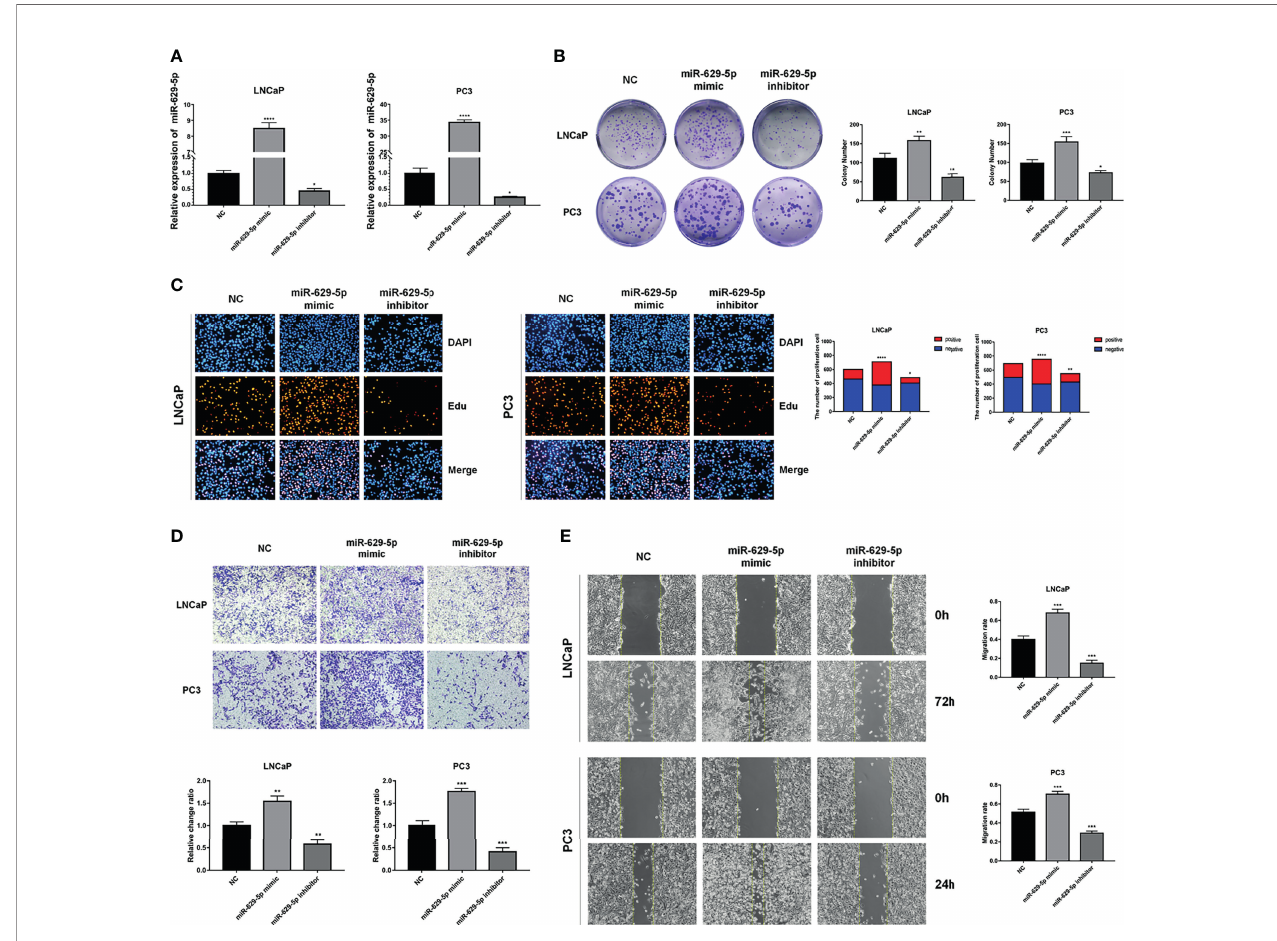
FIGURE 2 | MiR-629-5p facilitates PCa cells proliferation, migration, and invasion in vitro . (A) Stable miR-629-5p overexpression or inhibition PCa cell lines were established and con fi rmed by qRT-PCR. (B) Colony formation assays and (C) EdU assays were performed to assess the proliferation ability changes in miR-629-5p overexpressing or inhibitory cell lines. (D) Transwell assays and (E) Wound-healing assays were performed to assess the invasion and migration ability changes in miR-629-5p overexpressing or inhibitory cell lines. The data were presented as means ± SD from three biological replicates. *P < 0.05; **P < 0.01; ***P < 0.001; ****P < 0.0001; Student ’ s